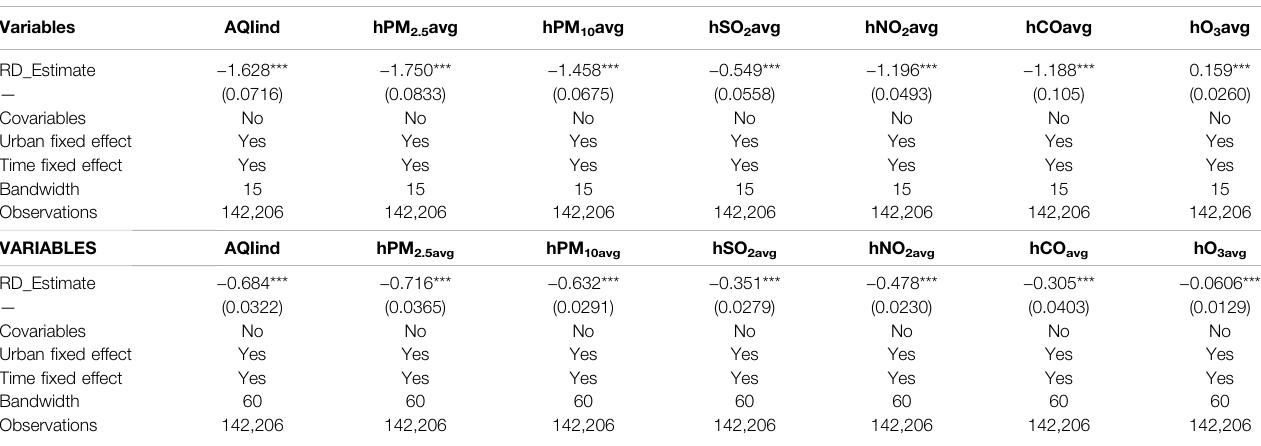
TABLE 6 | Results of different